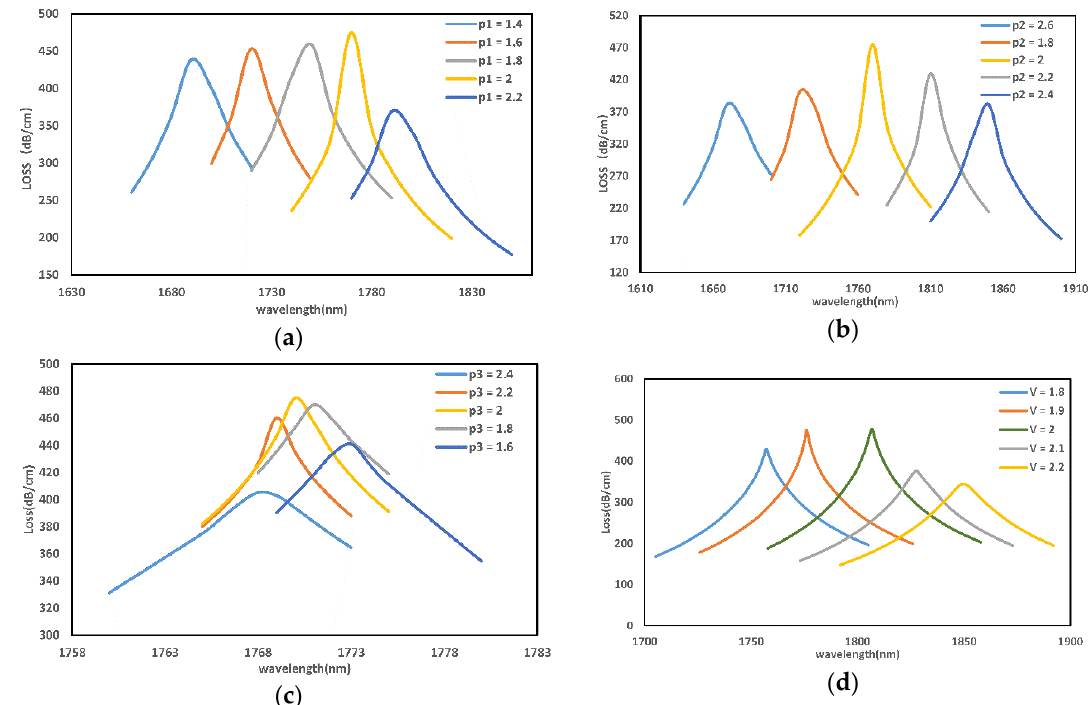
Figure 4. Loss spectra under different cladding air holes ( a ), germanium ‐ doped regions ( b ), air holes in the fiber core region ( c ), and lattice constant ( d ).